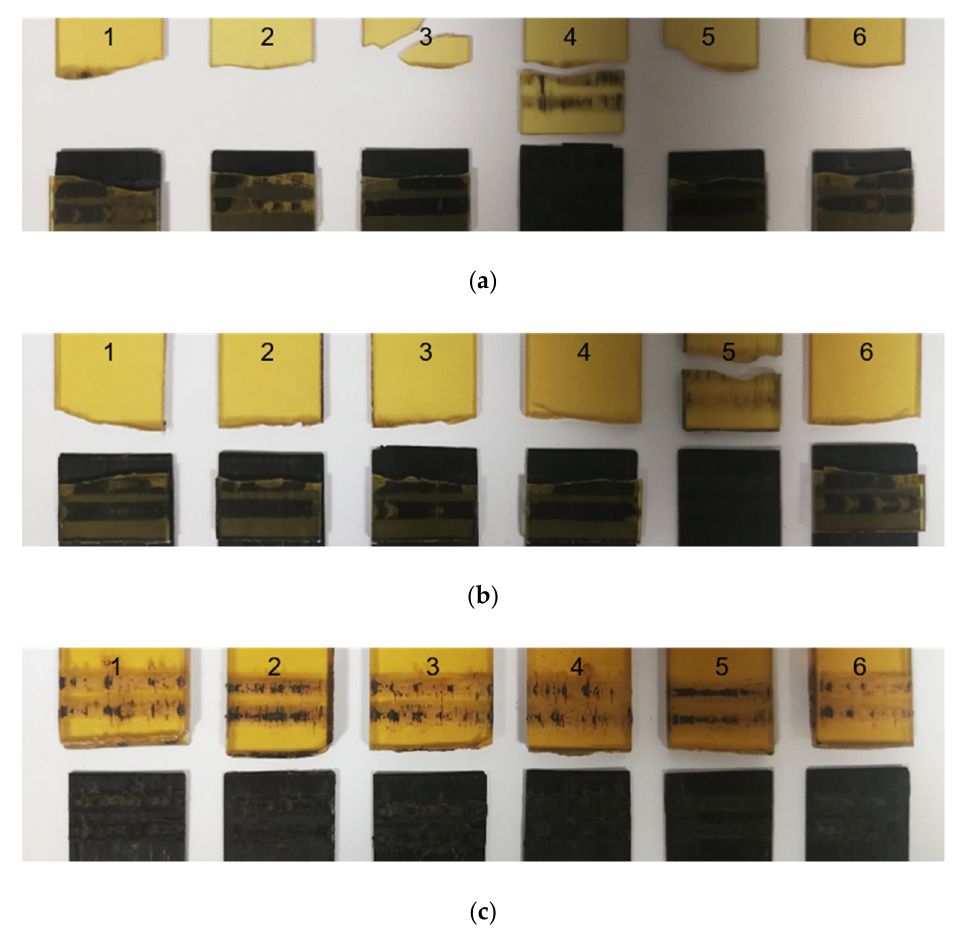
Figure 16. Fracture surface after LSS testing of transmission laser welded specimens from 1 to 6 for